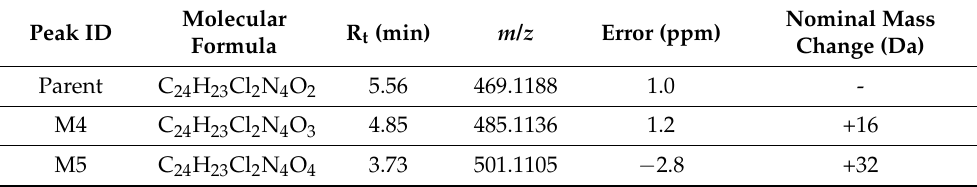
Table 2. Characterization of In vitro metabolites of 2 by